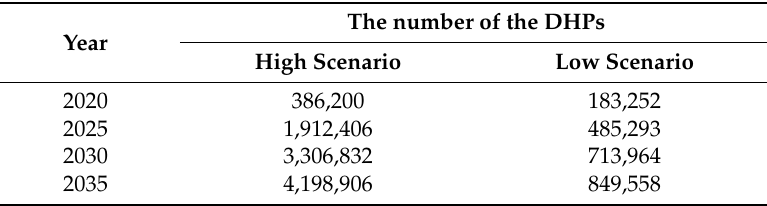
Table 2. The projected numbers of DHPs in the UK [9].